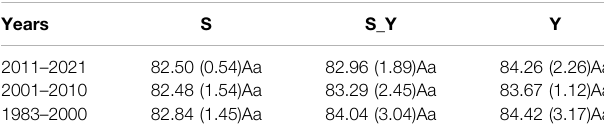
TABLE 1 | Grazing rate of each treatment (sheep unit month · ha − 1 ).